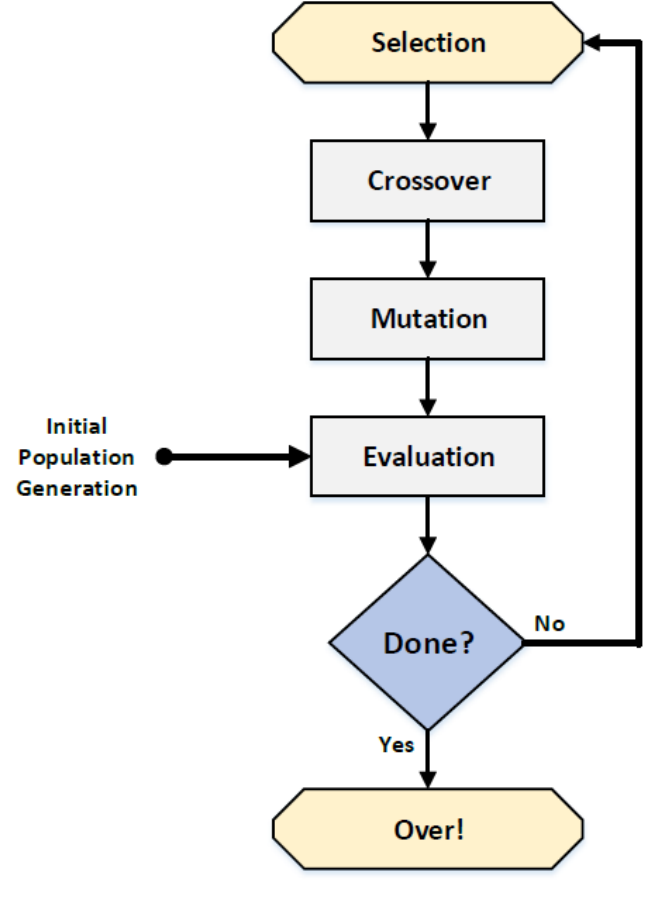
Figure 5. Flow chart of a typical